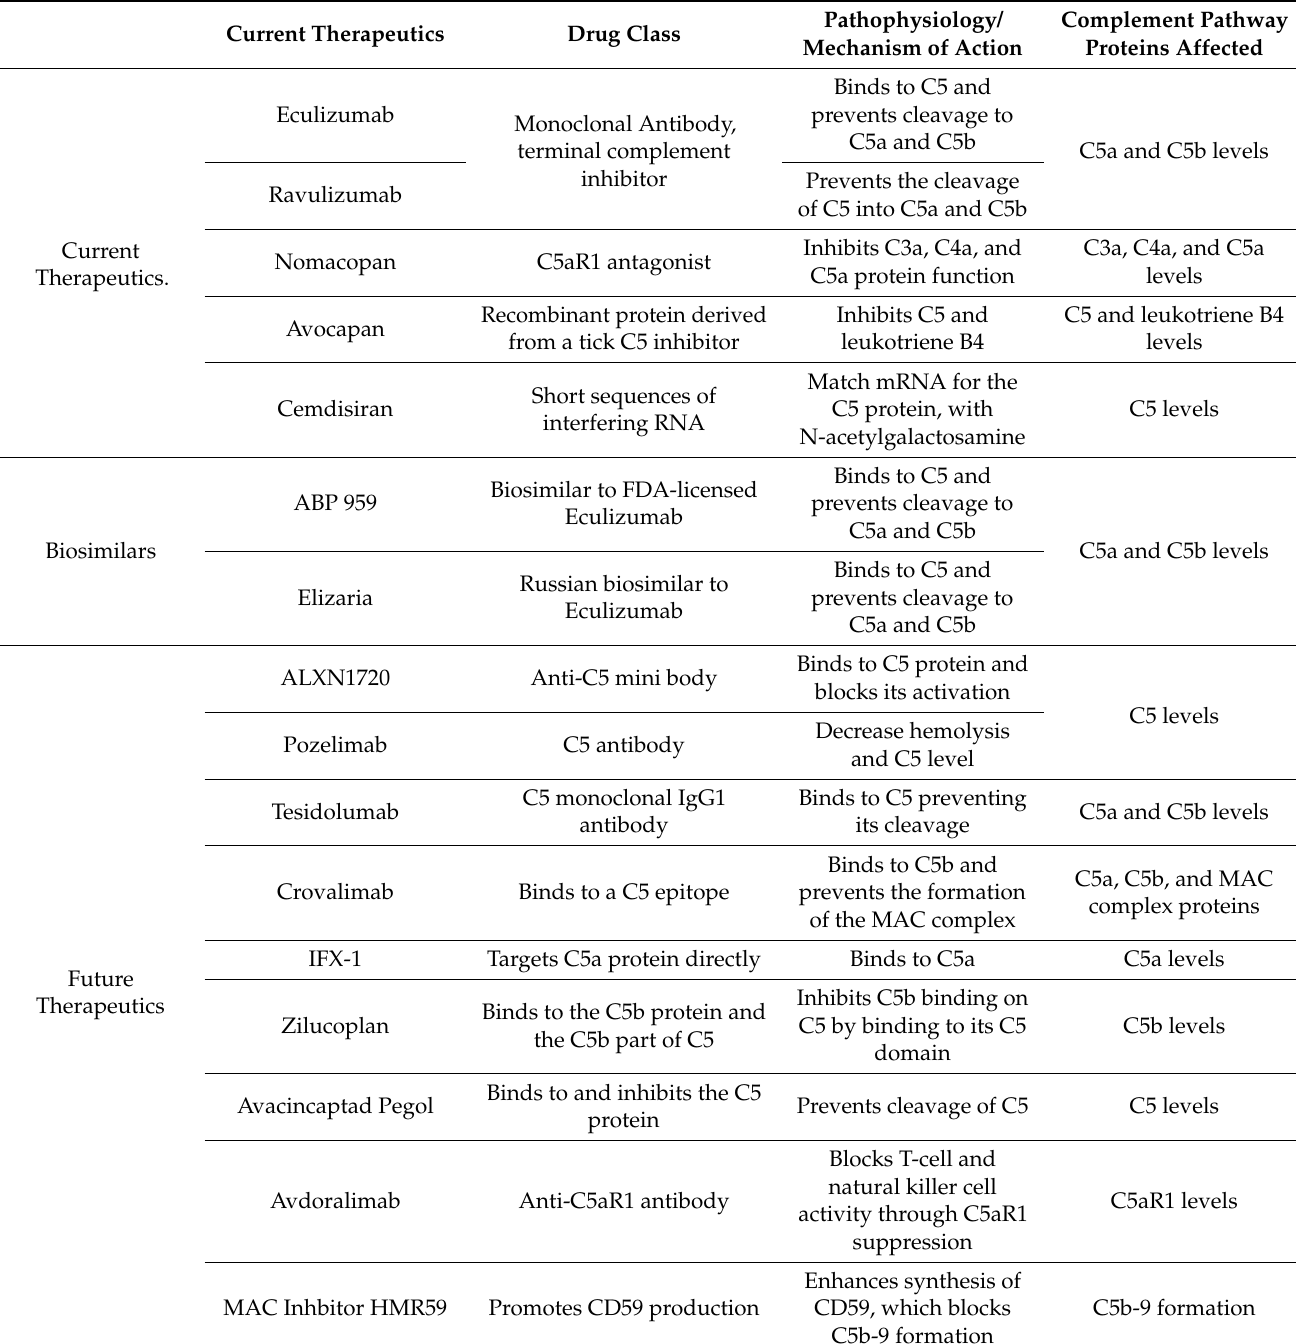
Table 6. Current, developing, and future therapeutics for